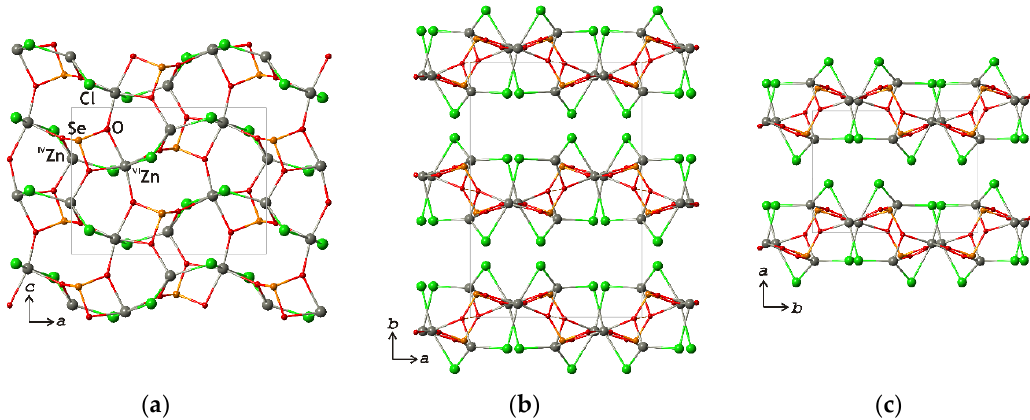
Figure 1. The crystal structures of the Zn 2 (SeO 3 )Cl 2 polymorphs: ( a ) the structure of the [Zn 2 (SeO 3 )Cl 2 ] 0 layer in sofiite; ( b ) the projection of the structure of sofiite parallel to the c axis; ( c ) the projection of the structure of β-Zn 2 (SeO 3 )Cl 2 parallel to the c axis. Legend: Zn, Se, Cl, and O atoms are shown as gray, orange, green, and red spheres, respectively.